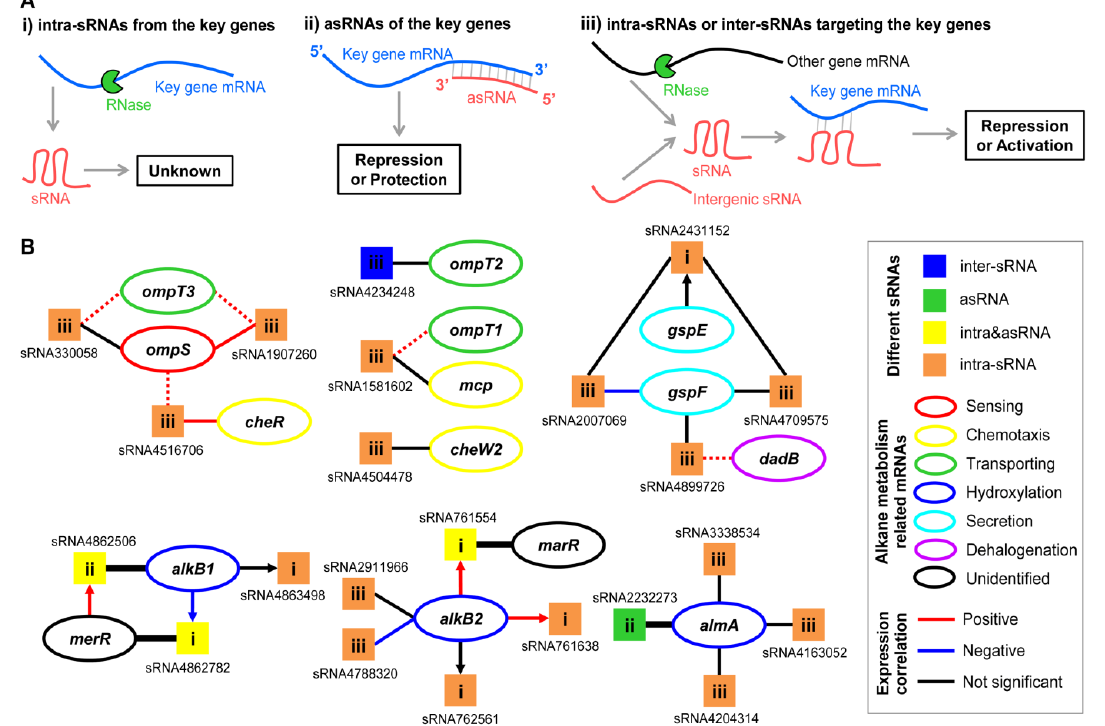
Figure 8. Putative relationships between the key genes in alkane metabolism and directly related sRNAs. ( A ) The three criteria to determine the directly related sRNAs with key genes of alkane metabolism. ( B ) Putative relationships between sRNAs and key genes. Each square represents a unique sRNA, and the sRNA identifiers are shown near the corresponding squares; the squares are colored according to the sRNA location-based classification. The ‘i, ii, iii’ in the squares correspond to the three criteria above. The ovals denote the mRNAs of key genes and are colored according to functions in alkane metabolism, and the related gene names are shown inside. The lines without an arrow show the matching relationships between sRNA and their targets, and the lines with arrows represent the sRNAs derived from the parental mRNAs. The cis -acting relationships (showing with wider lines) were deduced in terms of direct base-pairing for the asRNA and intra&asRNA, and the trans -acting relationships (showing with narrow lines) were inferred by IntaRNA prediction. The key genes in the top 10 most likely targets are shown with solid lines, and dotted lines show the potential targets beyond that range (top 20 to 100). The colors of lines or arrows indicate the correlationships of both of the connected ends based on Spearman correlation analyses of ssRNA-seq expression values in two carbon sources (n = 6).